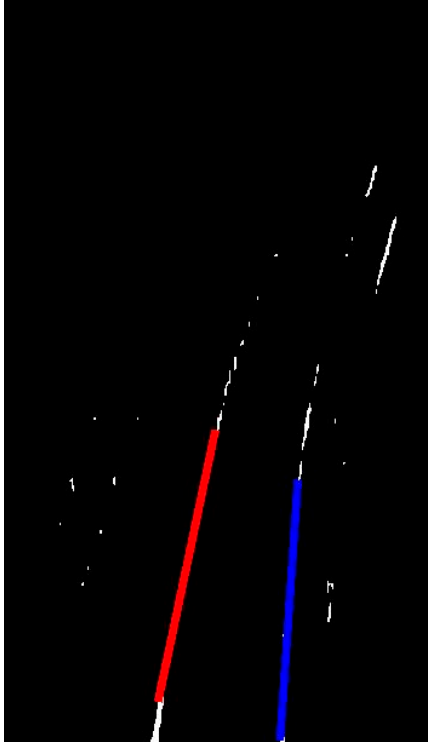
Figure 21. Hough transform result (the longest two lines).